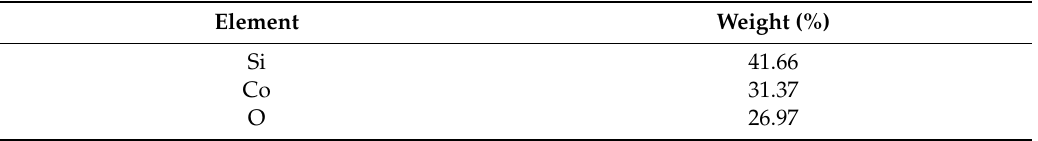
Figure 4. Field emission scanning electron microscopy (FESEM) images of ( a ) isotropic MRE and ( b ) anisotropic MRE with 53 wt % of cobalt. Table 4. Elements percentage in the